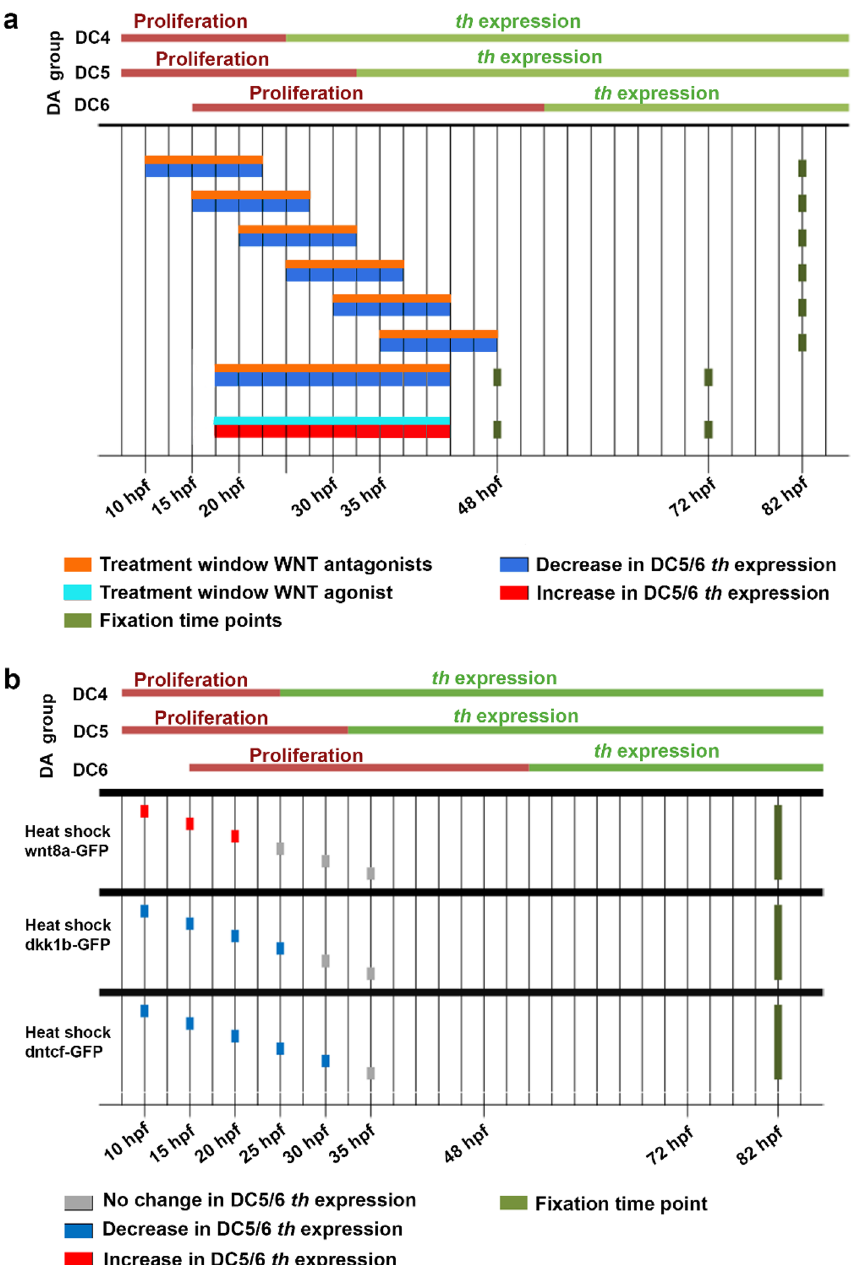
Figure 3. Summary of effects of inhibition and activation of Wnt/β-catenin signaling on hypothalamic DC5/6 DA neuron development. ( a ) Experimental design and summary of the results of pharmacological inhibition and activation of canonical Wnt signaling. The graph summarizes the findings from Figs. 4 and 5 and Supplementary Figs. 2 and 3. Top half of bars shows treatment time, bottom half color code for effect on DA neurons. Small molecule antagonists IWR-1 or XAV939 were applied for overlapping 12 h time windows (orange bars). The small molecule antagonist IWR-1 and the agonist BIO were also each applied from 18 to 42 hpf (orange and cyan bars). Small molecule and control treated embryos were fixed at 48 hpf for Wnt target gene axin2 expression analysis and either at 72 hpf or 80 hpf for th expression analysis (dark green dots). Color code indicates whether the treatment caused a decrease (blue) or an increase (red) in th expression as analyzed in embryos at either 72 or 80 hpf. The upper part indicates the temporal correlation of treatment windows and results of pharmacological manipulations to cell cycle exit and differentiation of DC4 and most of DC5 and DC6 DA neurons 25 . ( b ) Experimental design and summary of the results of heat-shock induced overexpression of Wnt8a, Dkk1b and a dominant negativeTcf3 (dnTcf3). The graph summarizes the findings from Figs. 6 and 7. Single heat shock treatments were performed at indicated time points (dots). Heat shocked heterozygous transgenic embryos and WT siblings were fixed as indicated (green dots) for th expression analysis. Color code indicates whether the treatment caused no change (grey), decrease (blue) or an increase (red) in th expression. The upper part indicates the temporal correlation to DA development as in ( a